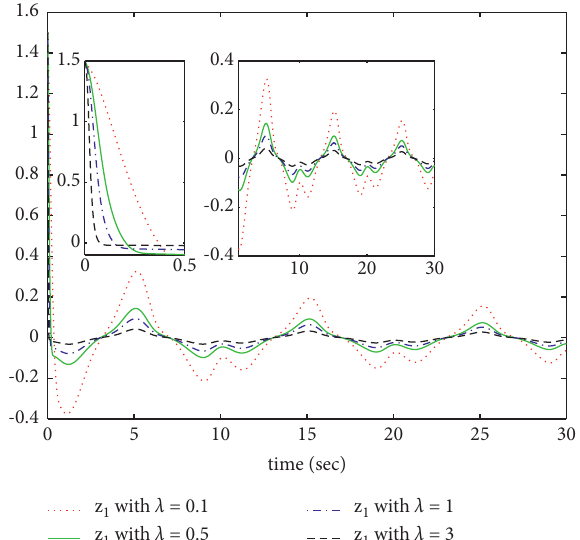
Figure 1: The tracking errors with different λ